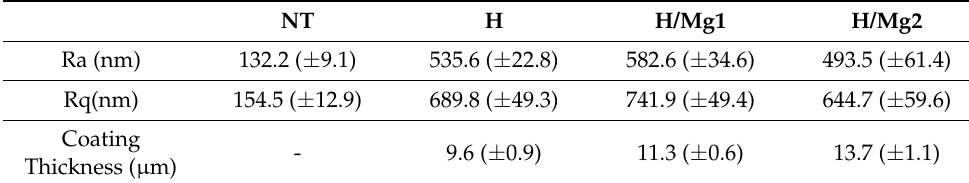
Figure 7. Representative profile lines of the investigated materials. Table 5. Main roughness parameters and coating